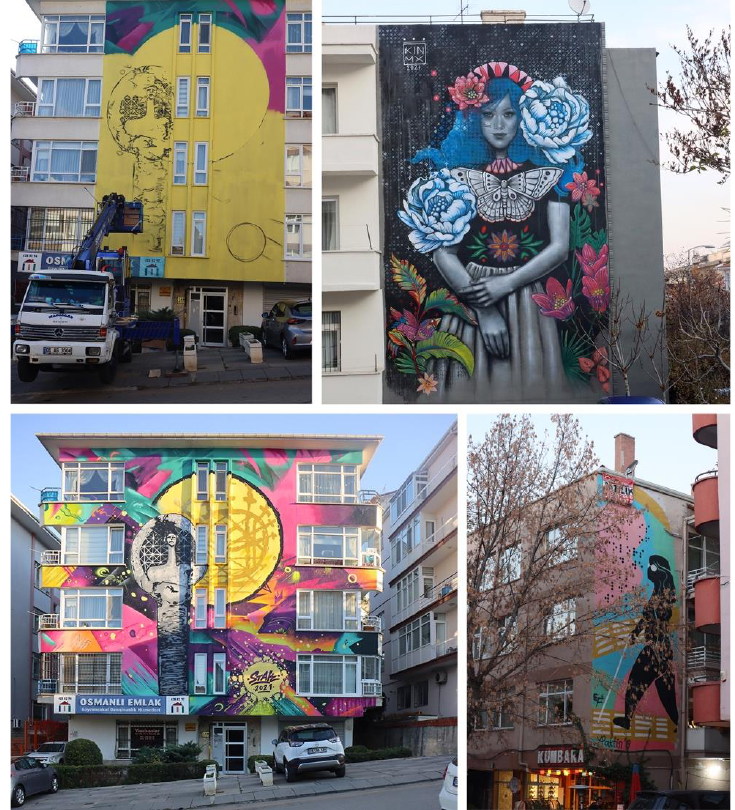
Figure 5 Some applications within the neighborhood fabrics of Ankara (Source: C.G. Yaşar’s personal archive, 2021)